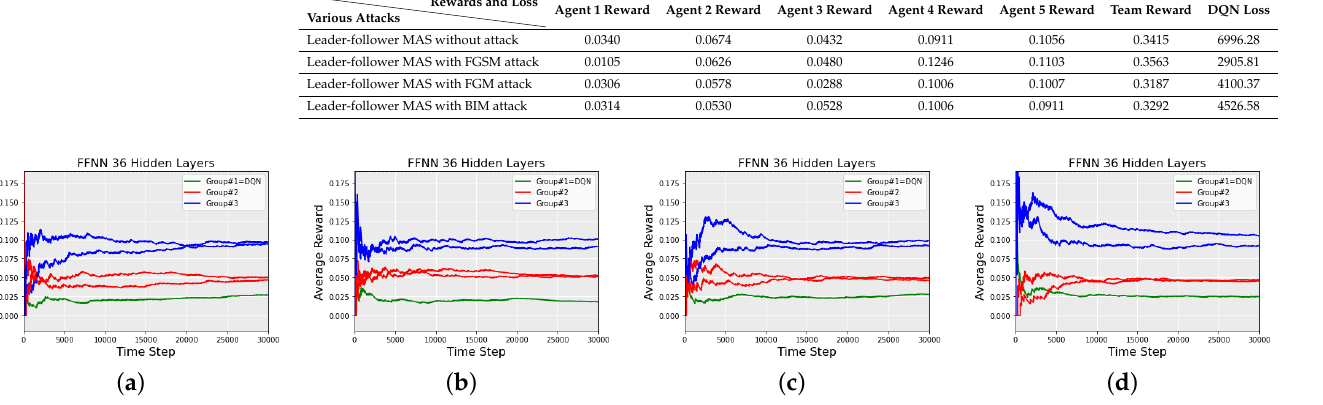
Figure 13. Reward convergence of a heterogeneous leader-follower MAS, including N = 5 agents in P = 3 different clusters, during 30,000 time steps by considering time-delay and distance-based reward after adversarial attack defense Algorithm 2. ( a ) Average reward of a leader-follower MAS without adversarial attack. ( b ) Average reward of a leader-follower MAS after defending against FGSM adversarial attack. ( c ) Average reward of a leader-follower MAS after defending against FGM adversarial attack. ( d ) Average reward of a leader-follower MAS after defending against BIM adversarial